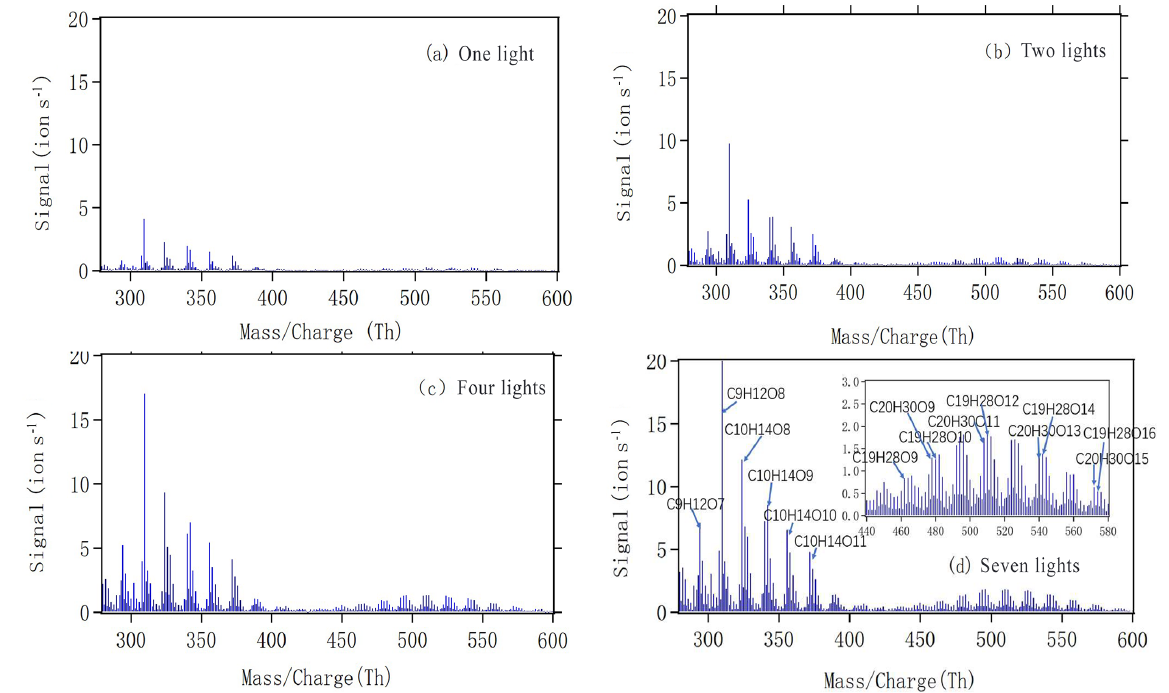
Figure 4. The mass spectra obtained by NO 3 CI-APi-ToF during steady state with one (a) , two (b) , four (c) and seven (d) lights. All peaks are detected as clusters with NO − . The spectra are plotted as unit mass resolution, with background signals removed, but the peak identifications 3 (labelled in panel d ) are based on high-resolution analyses. The spectra correspond to the same four steady-state conditions depicted in Fig. 2.